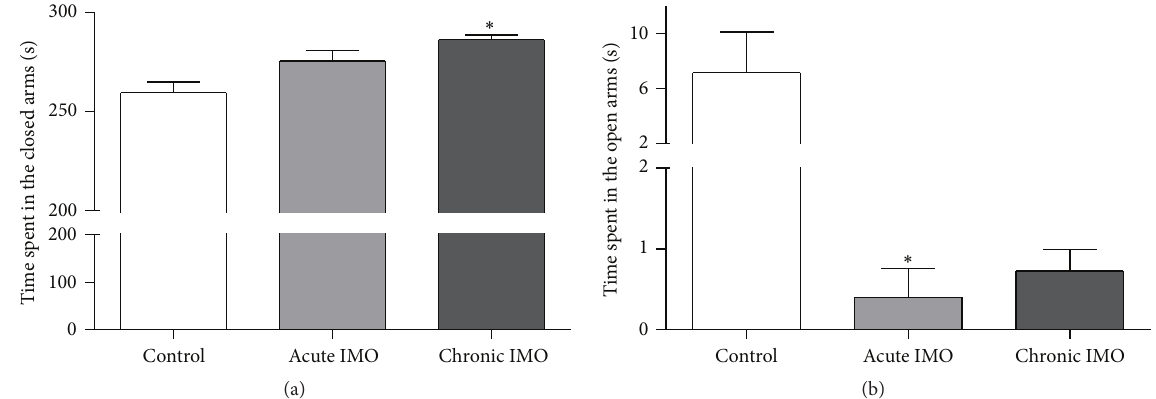
Figure 1: Mean ( ± SEM) time spent in the closed arms and the open arms during EPM test for the acutely and chronically stressed and control rats. (a) Chronic IMO induced a significant increase in time spent on the closed arms. (b) Acute IMO led animals to stay for significantly less amount of time in the open arms. ( 𝑛 = 6 per group) ∗ 𝑃 < 0.05 versus control; ANOVA.